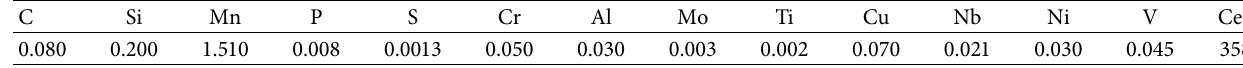
Table 1: Chemical composition of Q460 (%).